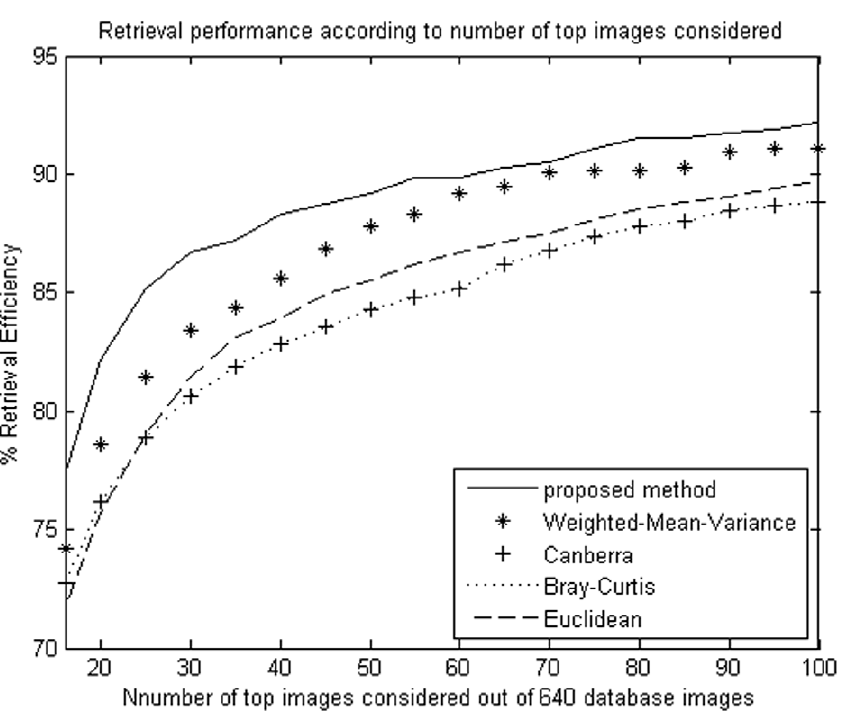
Figure 5. Average retrieval rate of database according to the number of top retrieved images using NSCT. The MIT image database (640 images) were used.